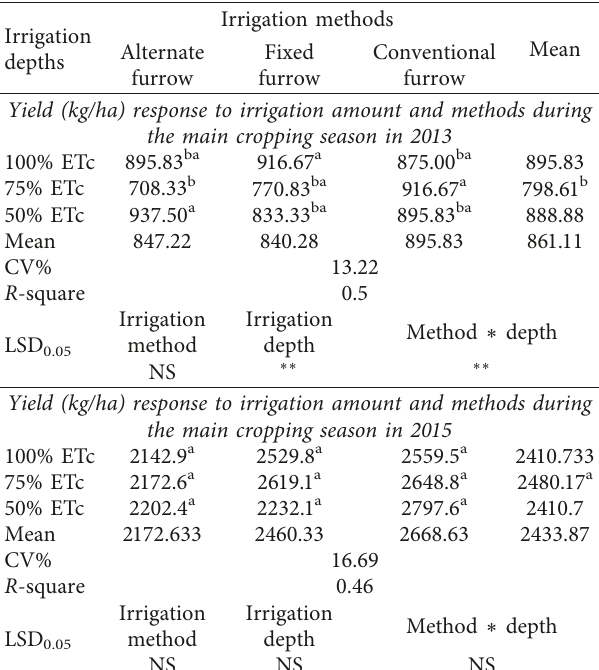
Table 1: Treatment combinations. Irrigation amount